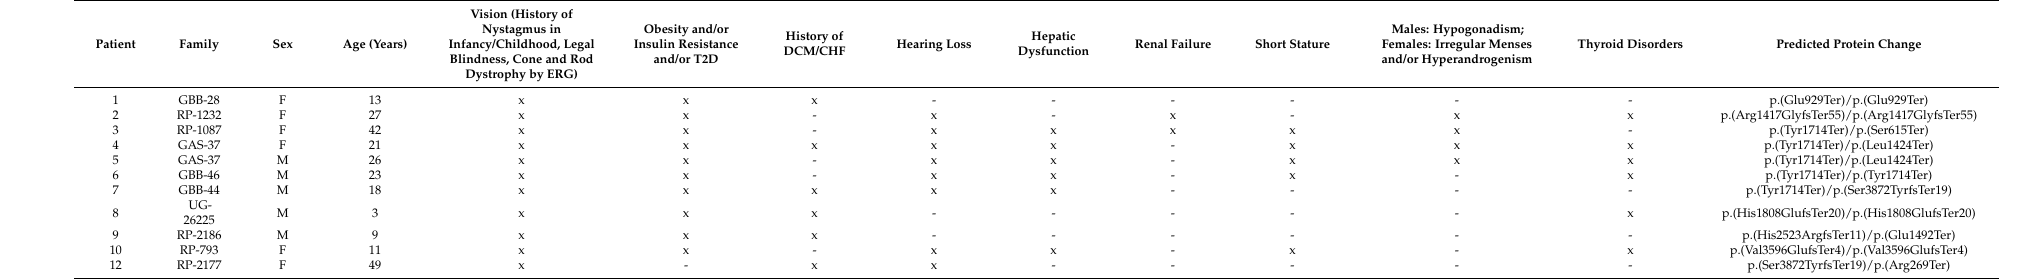
Table 2. Phenotype summary based on the diagnostic criteria for Alström syndrome according to Marshall et al. (2007) [9] for 11 of the 12 cases. The clinical history of patient GBB-45 was not available. x: presence of symptom. -: absence of